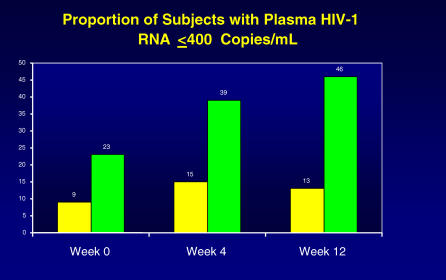
Antiviral Efficacy of ABCThe percentage of participants in the two arms of the trial (ABC arm is the further bar to the right at each time point) on the y-axis with undetectable plasma HIV viral load at the beginning, week 4, and at the end of the trial (week 12).